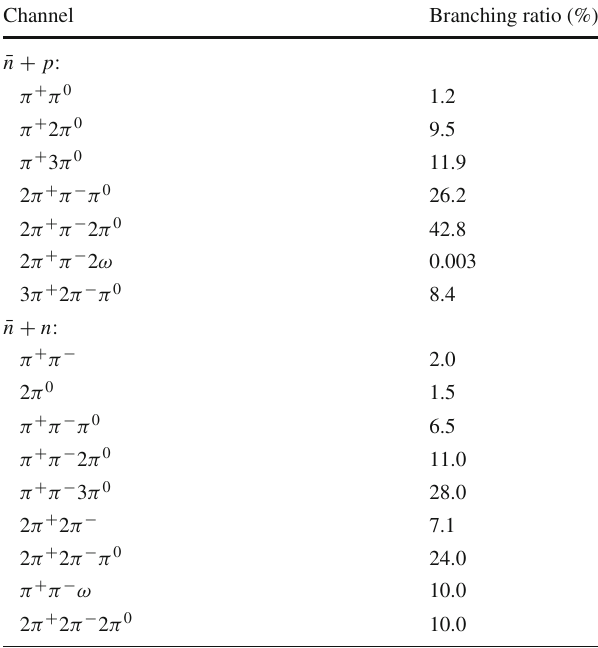
Table 9 Effective branching ratios for antineutron annihilation in 40 Ar, as implemented in GENIE